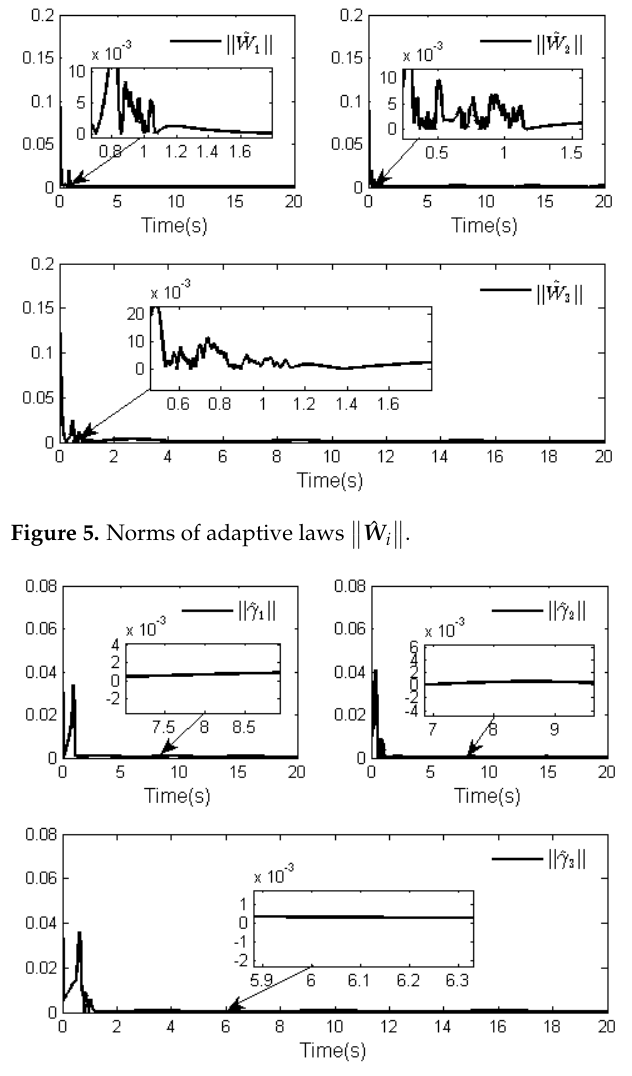
 . Figure 6. Norms of adaptive laws (cid:107) ˆ γ i (cid:107) i